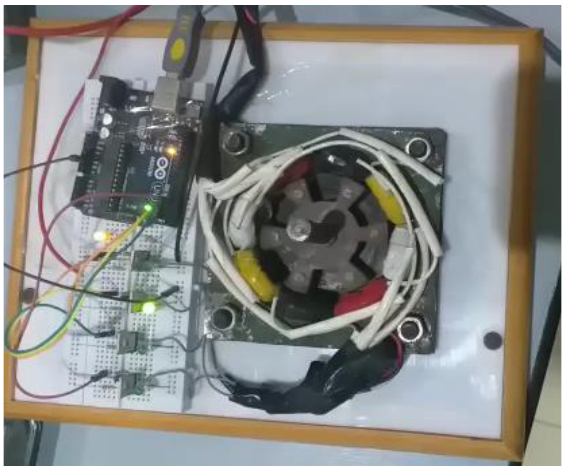
Fig. 6. 8/6 pole SR Motor, its drive and control circuit in